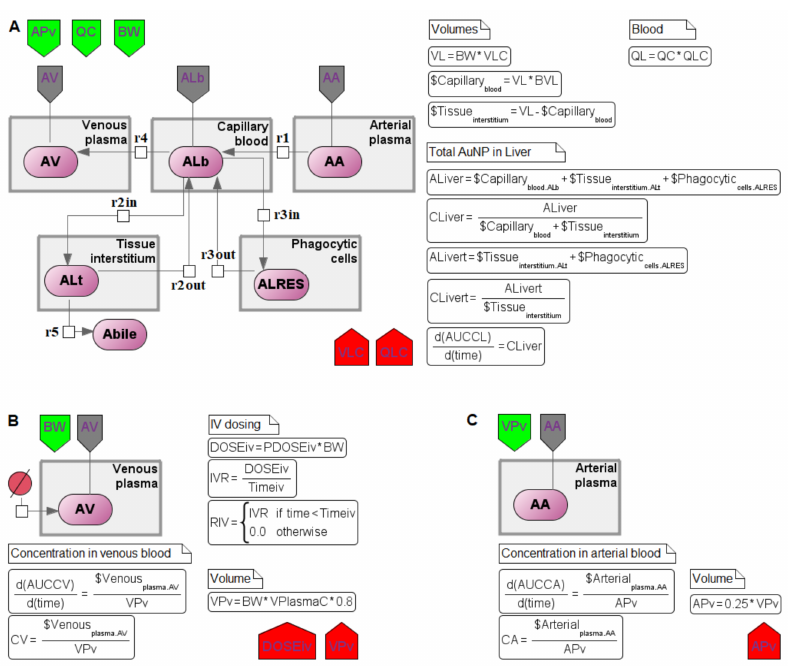
Figure 10. Determination of the PBPK model of nanoparticle delivery to solid tumors in mice based on the modular approach. ( A ) Module “Liver”. ( B ) Module “Venous plasma”. ( C ) Module “Arterial plasma”.